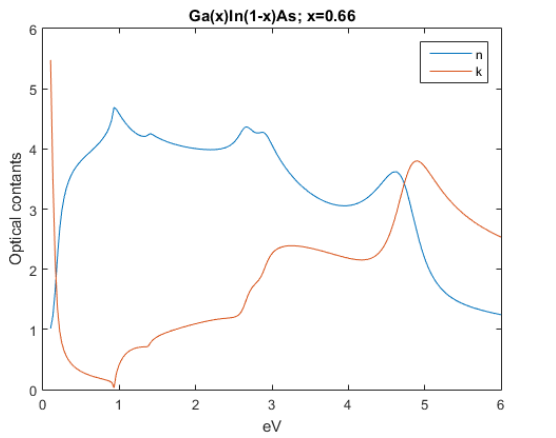
Figure 7. Real and imaginary optical constants of Ga 0.66 In 0.34 As .